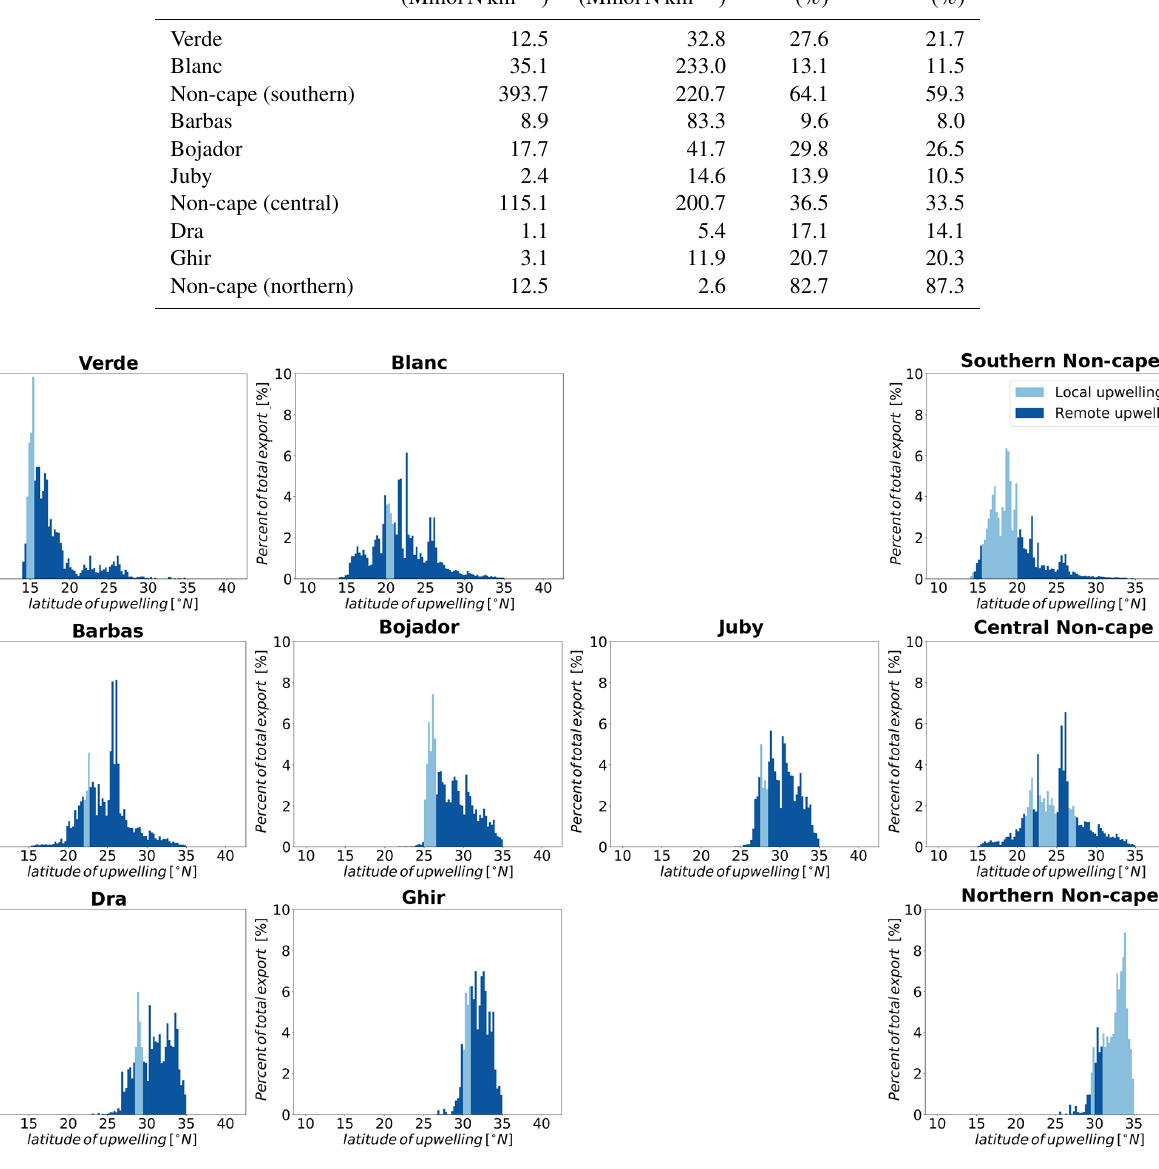
Figure 9. Latitude of upwelling of nitrogen exported at each cape or non-cape